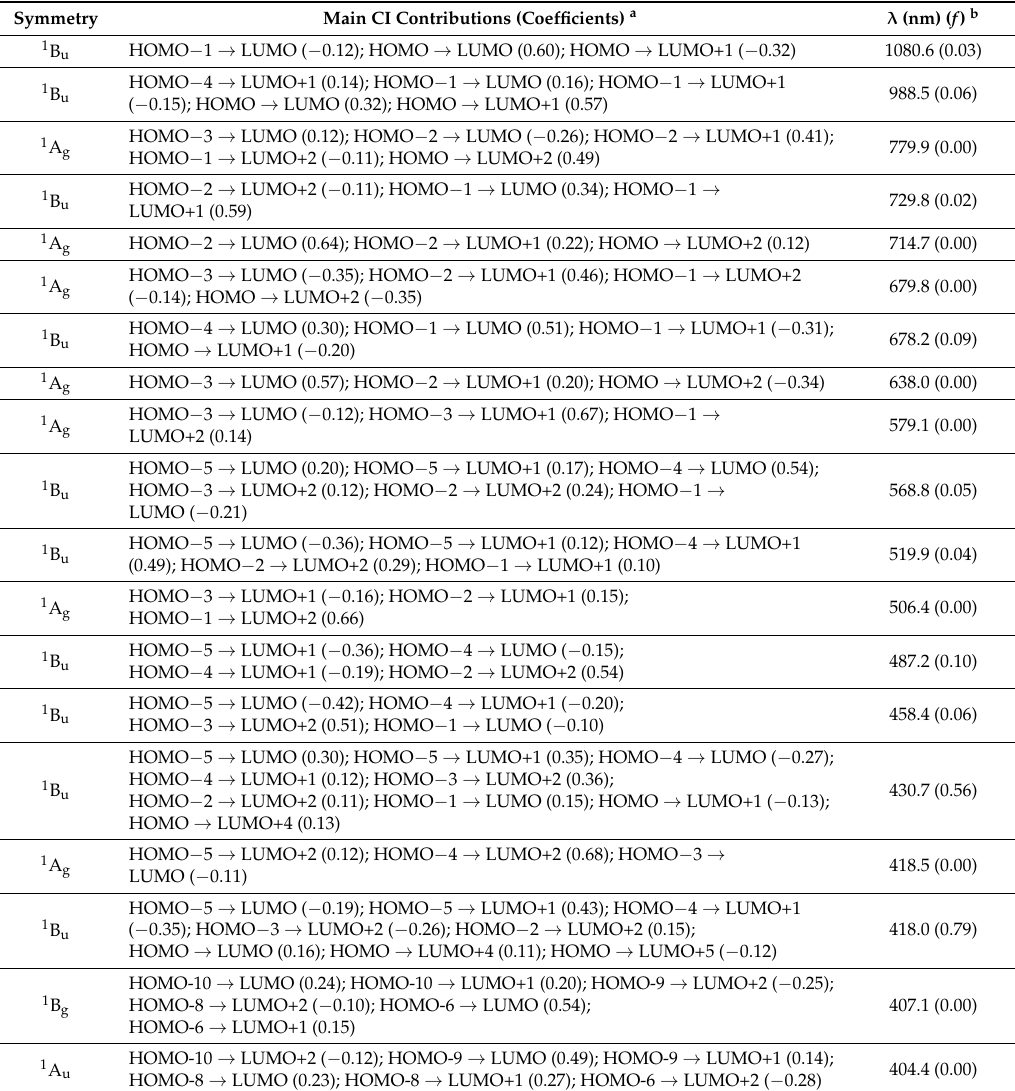
Table 14. Excitations underlying the UV–Vis spectrum of a16_b6_c16_d6, computed at the C 2h geometry in